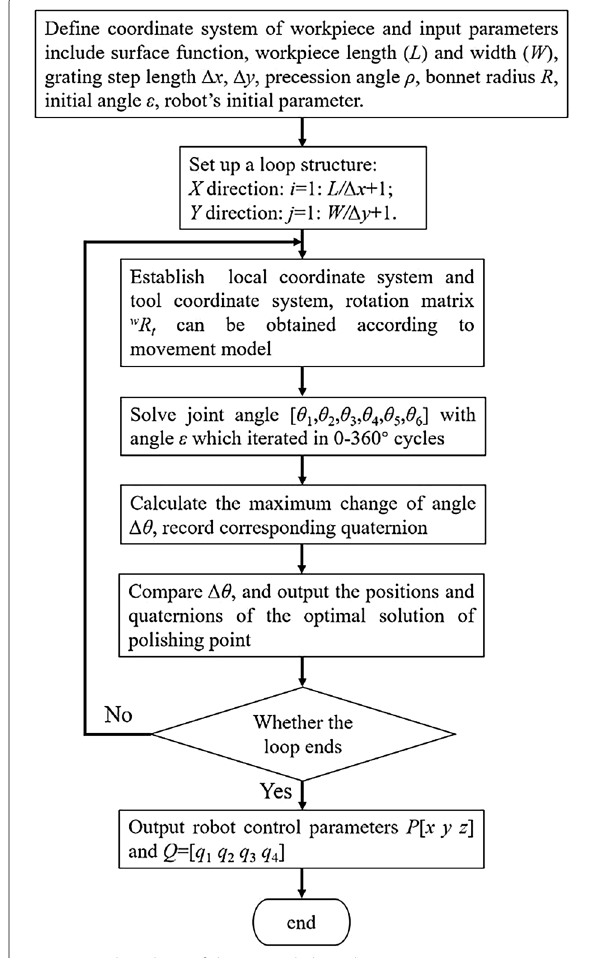
Figure 3 Flowchart of the control algorithm